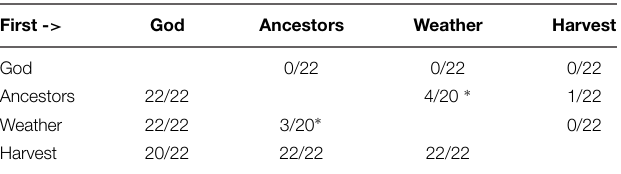
FIGURE 2 | When asked specifically to organize the cards to a causal flow, 11 informants produced this